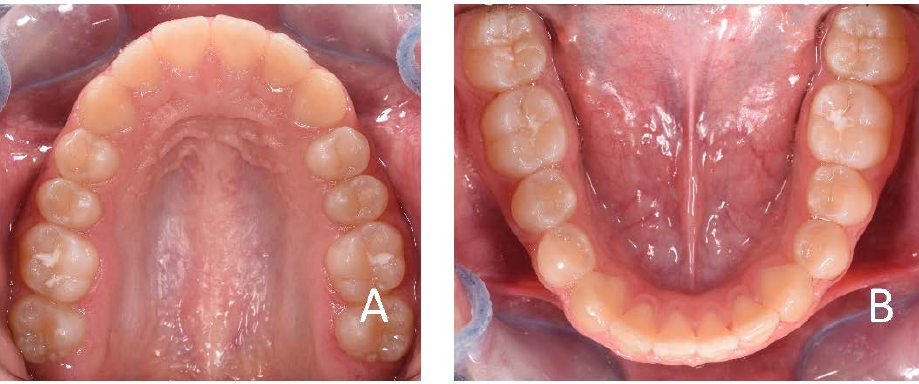
Figure 8. Intraoral photographs after the treatment and a 3-year follow-up period (14-year-old). ( A ) Frontal view; ( B , C ) lateral view.